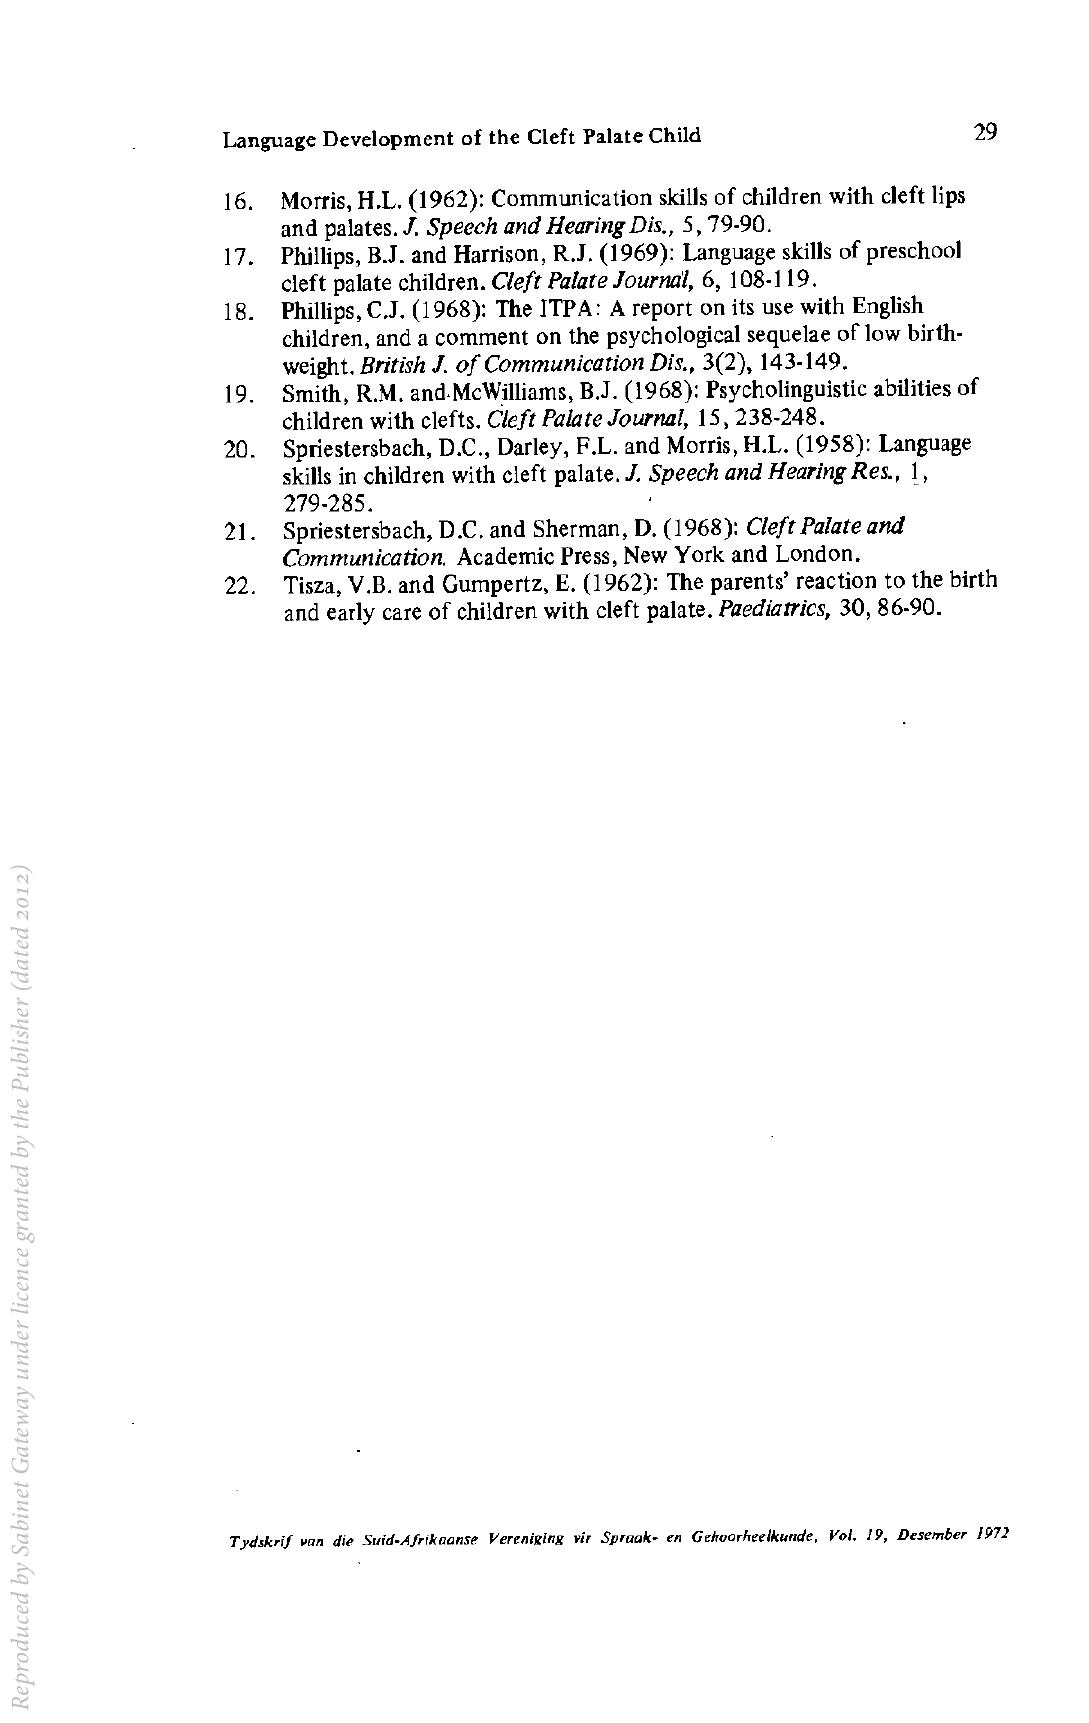
Tydskrif van die Suid-Afrikaanse Vereniging vir Spraak- en ehoorheelkunde, Vol. 19, Desember